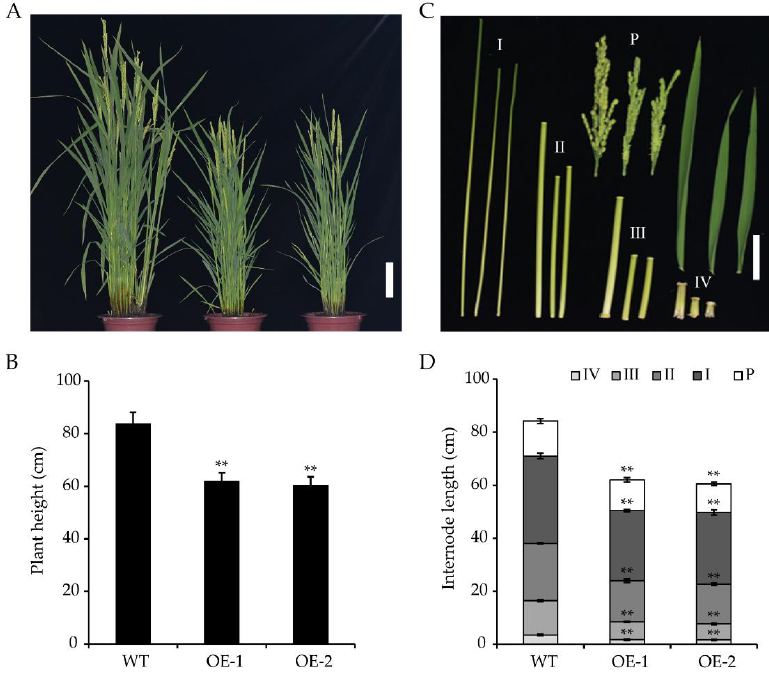
Figure 4. Overexpression of OsWRKY55 reduces plant height. ( A ) Phenotypes of wild-type (WT) plants and transgenic lines overexpressing OsWRKY55 (OE-1 and OE-2). Scale bar = 10 cm. ( B ) Heights of mature WT and OE plants. ( C ) Panicles (P) and internodes (I-IV) of mature WT and OsWRKY55- OE plants. Scale bar = 5 cm. ( D ) Lengths of panicles (P) and internodes (I-IV) in mature WT and OsWRKY55- OE plants. In all graphs, values shown are means ± SD (n ≥ 15), ** p < 0.01 (Student’s t -test).